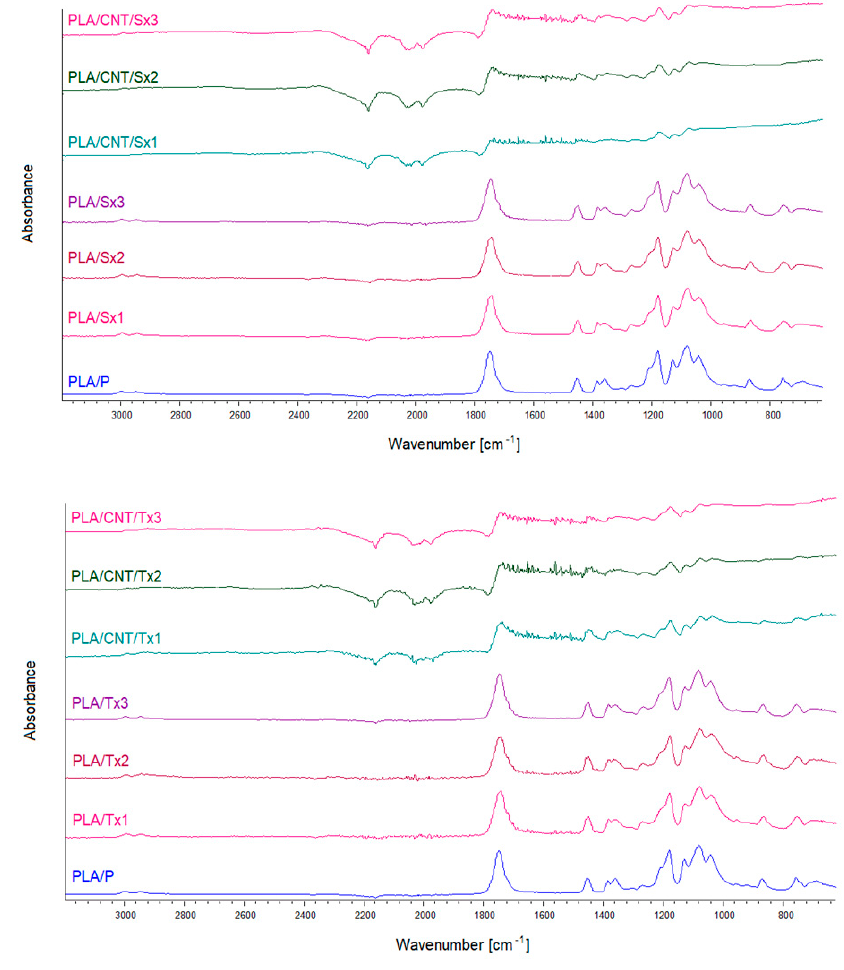
Figure 5. ATR-FTIR spectra of neat PLA and PLA/MWCNT composite subjected to the single, double, and triple extrusion. Upper panel shows spectra of samples subjected to the single-screw extrusion, bottom panel refers to the twin-screw extrusion. At the bottom of each panel, spectrum of the neat unprocessed PLA (PLA/P) is shown as the